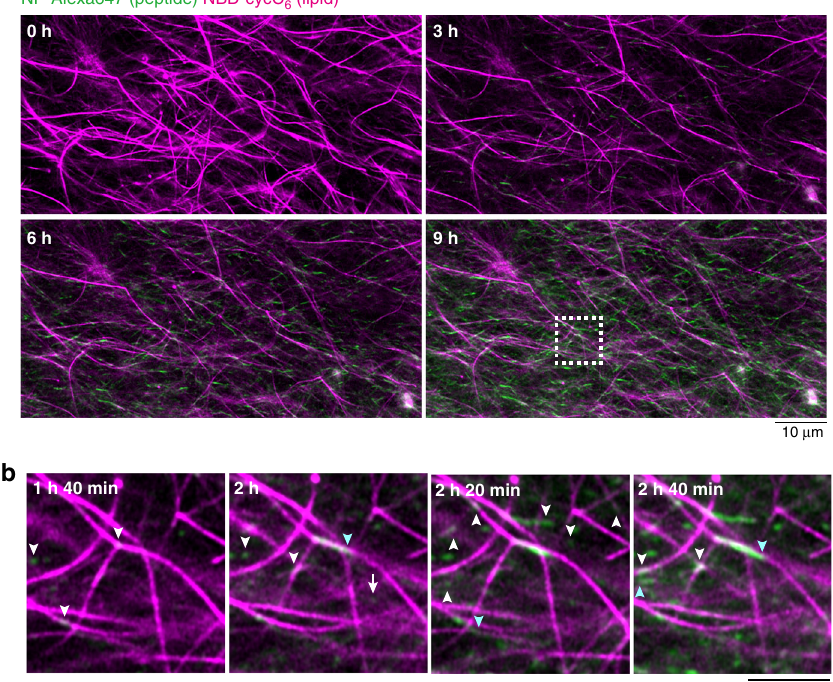
Fig. 6 Real-time imaging of formation process of the parallel self-sorting network. a Time-lapse imaging of the formation process of the parallel SDN. b Magni fi ed view of seed formation on the surface of lipid-type nano fi bers (a white square in Fig. 6a). White and sky blue arrowheads represent the sites of seed formation and elongation on the surface of lipid nano fi bers, respectively. Green: NP-Alexa647 , magenta: NBD-cycC 6 . Condition: [ Ald-F(F)F ] =